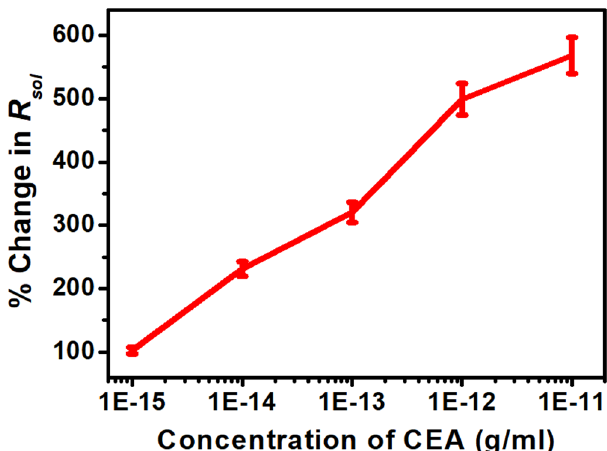
Figure 8. Rsol versus CEA concentration.